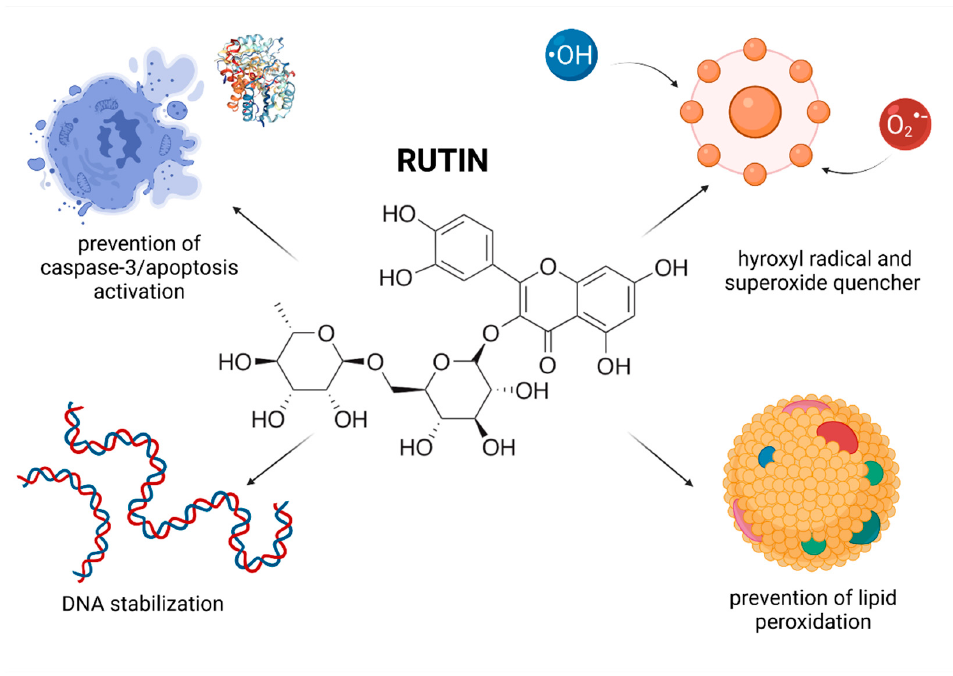
Figure 6. Most frequently reported beneficial effects of rutin on spermatogenesis, sperm structural integrity and functional activity. integrity and functional